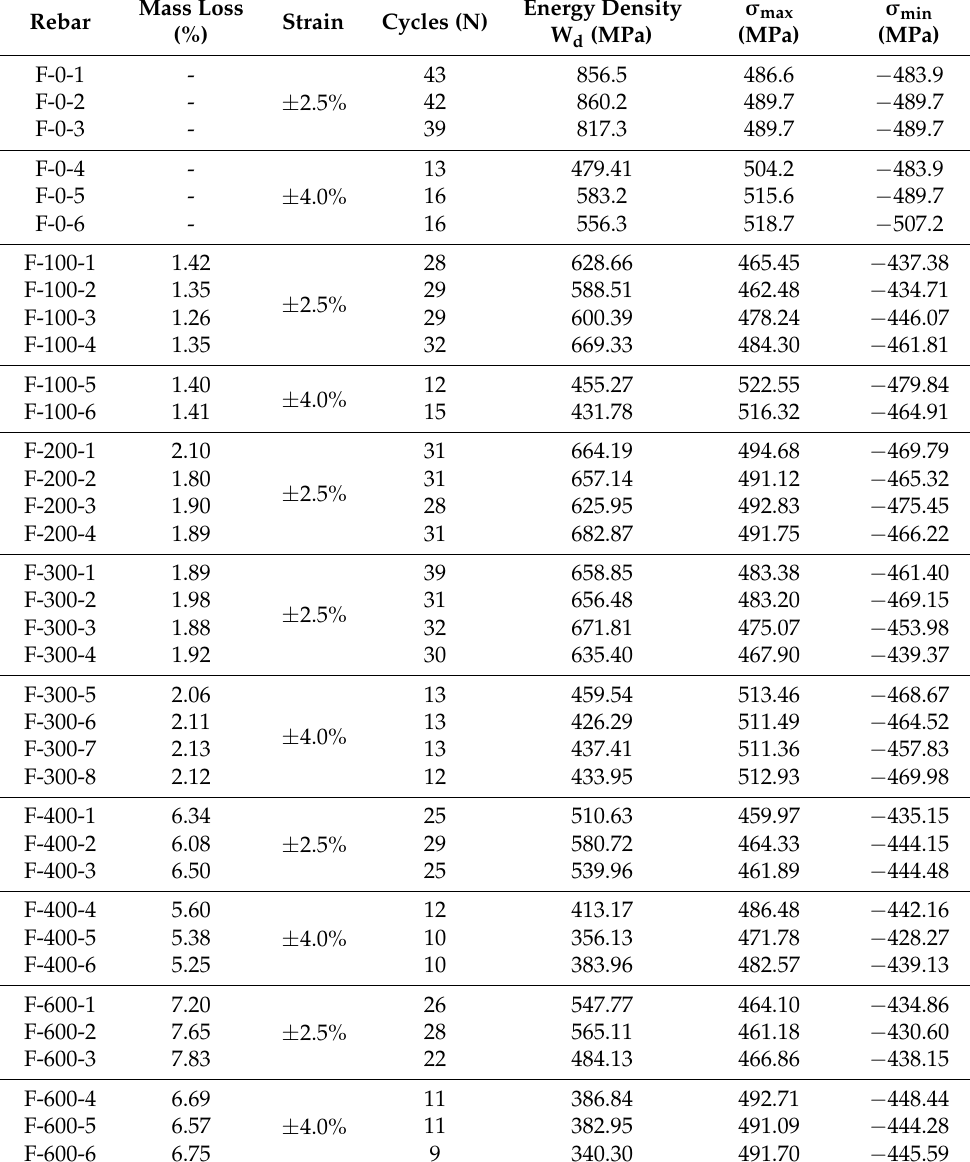
Table 6. Results of LCF tests with free length 6Ø conducted on steel Dual Phase F